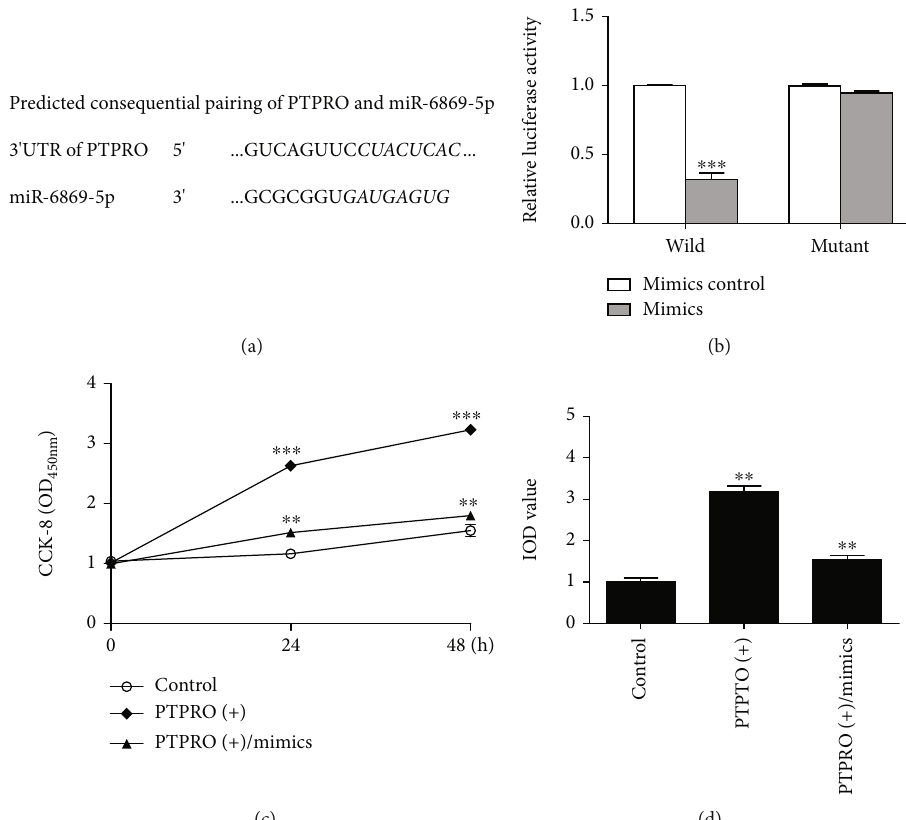
Figure 3: MiR-6869-5p regulated the proliferation of macrophage by targeting PTPRO. (a) The predicted consequential paring of miR-6869- 5p and PTPRO 3 ’ UTR. (b) The luciferase reporter assay: the activity of luciferase was signi fi cantly decreased in PTPRO wild type group compared with the PTPRO mutant type group in THP-1 macrophages treated by miR-6869-5p mimics ( ∗∗∗ P < 0 : 001 ). (c) CCK-8: miR- 6869-5p mimics inhibited the proliferation of macrophage although PTPRO was overexpressed (compared with the control group, ∗∗∗ P < 0 : 001 ; compared with the PTPRO (+) group, ∗∗ P < 0 : 01 ). (d) EdU: miR-6869-5p mimics inhibited macrophage proliferation (representative pictures of EdU assay and data of three independent experiments; compared with the control group, ∗∗ P < 0 : 01 ; compared with the PTPRO (+) group, ∗∗ P < 0 : 01